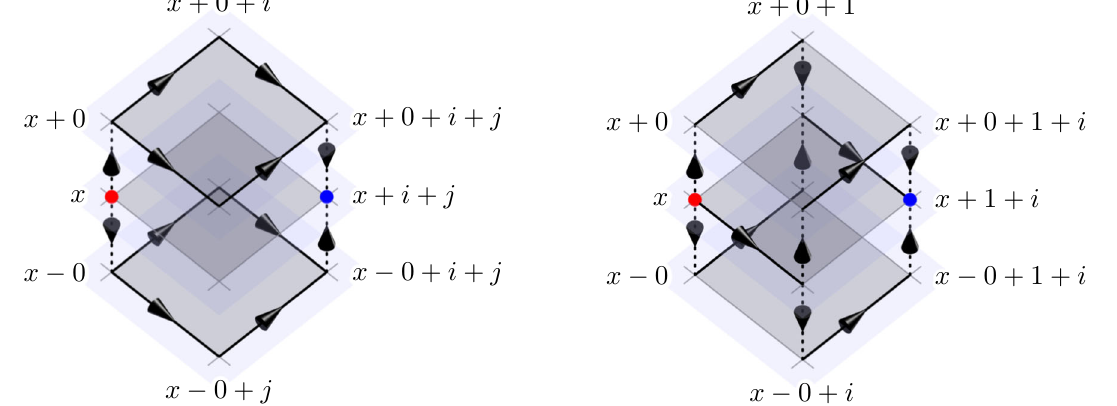
temporal link connections only at the start and end points. Therefore the diagonal from x to x + i + j is a preferred direction. This asymmetry can be repaired by including M x , i − j terms in the action (140). We can also see that in the continuous time limit (the vertically stacked time slices would merge into one) the paths traced by M x , ij and W x , 1 i would become identical to C x ,